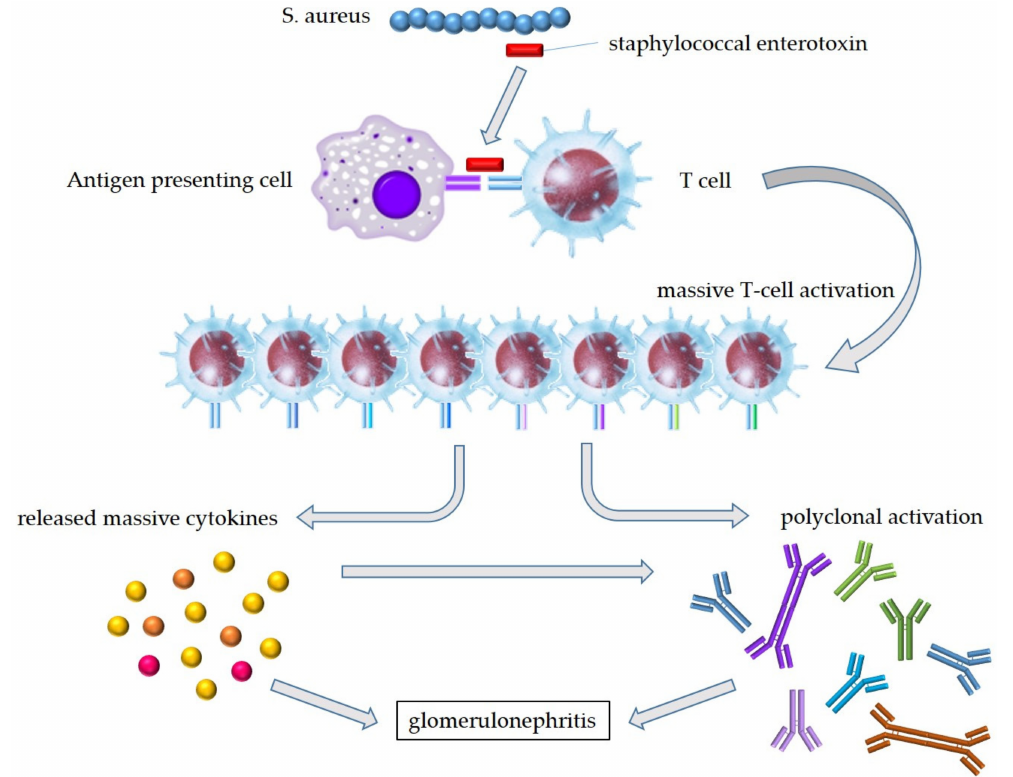
Figure 4. Hypothesis of pathogenesis in SAGN with IgA-dominant deposition. Staphylococcal enterotoxins produced by S. aureus bind to specific TCR-V β on T cells and the outer part of the MHC molecules without being processed. Bacterial superantigens lead the MHC-unrestricted huge T-cell activation. The subsequent excessive release of cytokines activates not only T cells but also B cells; the polyclonal immunoglobulin production leads to the formation of immune complexes, resulting in the onset of SAGN. S. aureus — Staphylococcus aureus